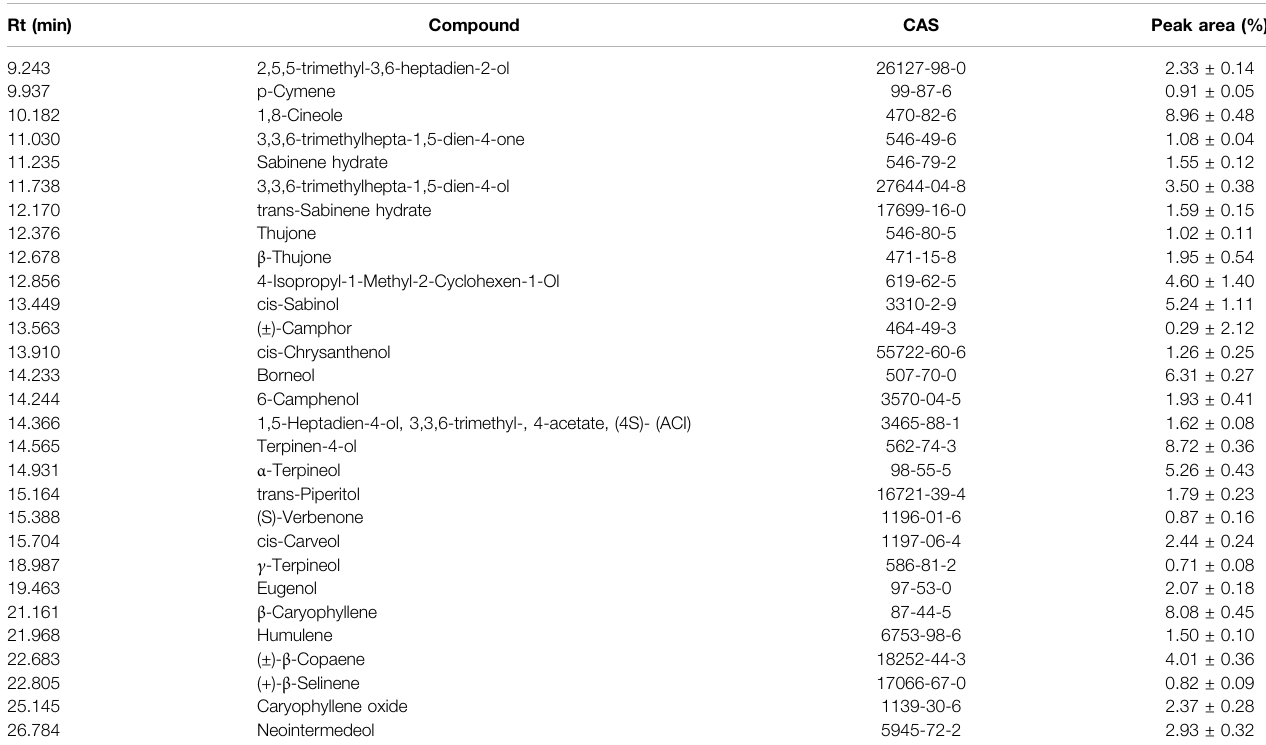
TABLE 1 | Chemical compositions of SFEAO. Rt (min)